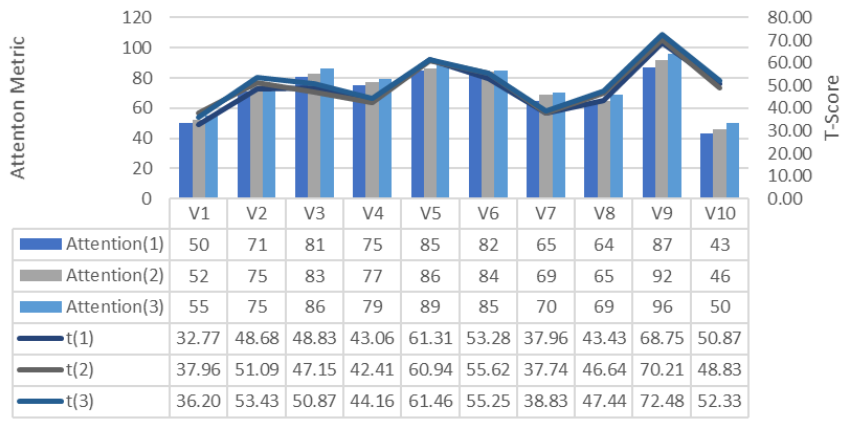
Figure 13. Change in attention per lap on the GDTS track.